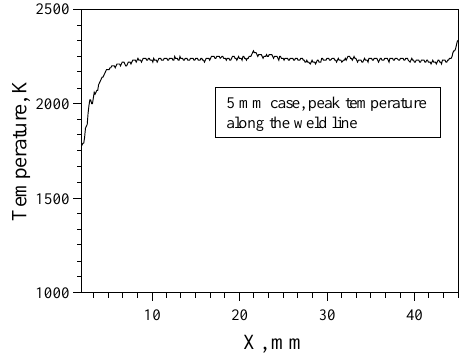
Figure 10. Simulated peak temperature along the weld centerline for the 5mm case.